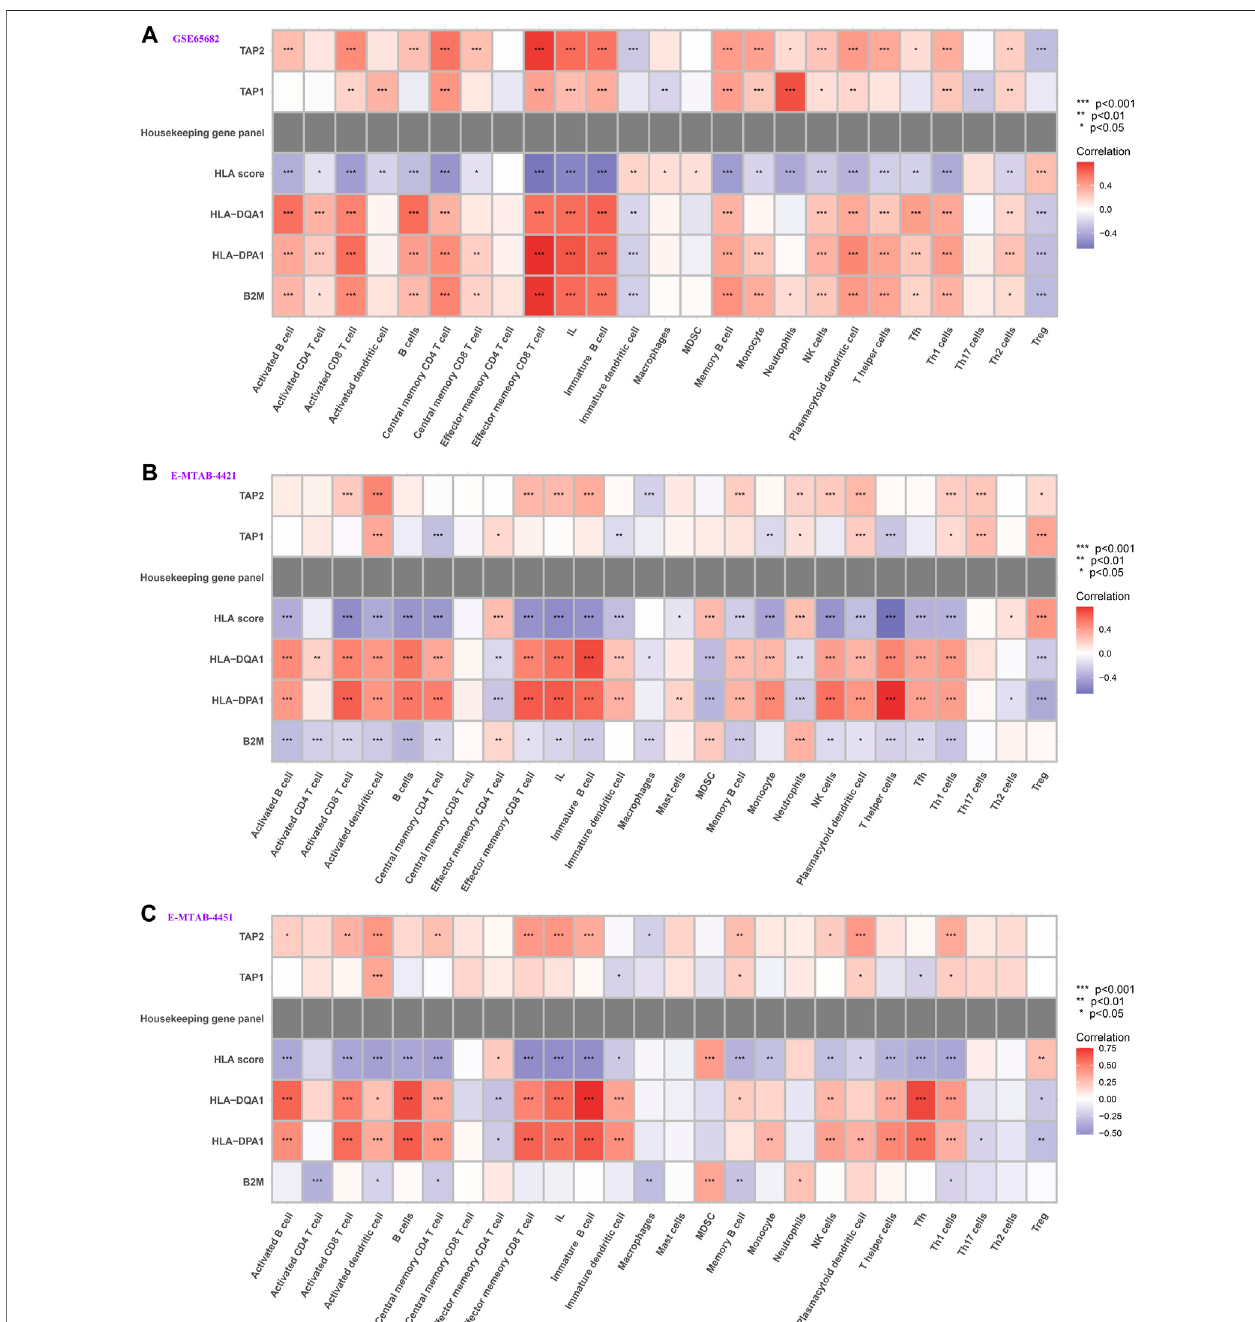
FIGURE 8 | Correlation between HLA classi fi er/genes and immune cells in multiple transcriptome datasets. (A) GSE65682 datasets. (B) E-MTAB-4421 datasets. (C) E-MTAB-4451 datasets.